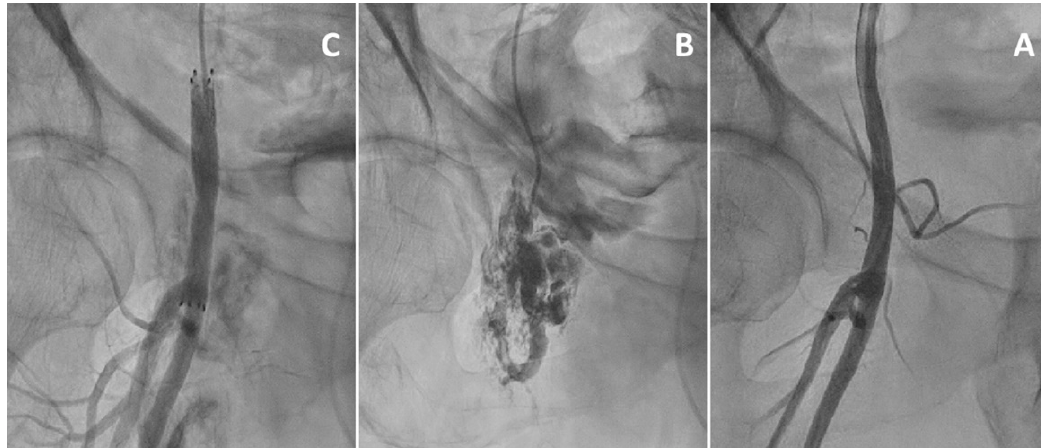
Figure 2. Secondary VCD failure. An 86-year-old female underwent transfemoral TAVR via the right femoral artery ( A ). Vessel pre-closure was performed with a Prostar XL device. Control angi- ogram performed following removal of the 16 Fr sheath and fastening of the Prostar sutures re- vealed femoral artery perforation ( B ). A Fluency 9 × 60 mm stent graft which was delivered from the contralateral femoral artery achieved hemostasis ( C ).